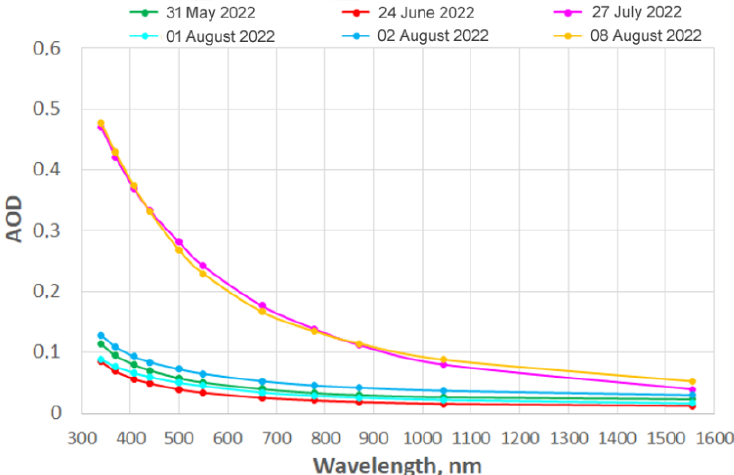
Figure 9. Spectral variability of the AOD on the dates of subsatellite measurements for the Gorky Reservoir.